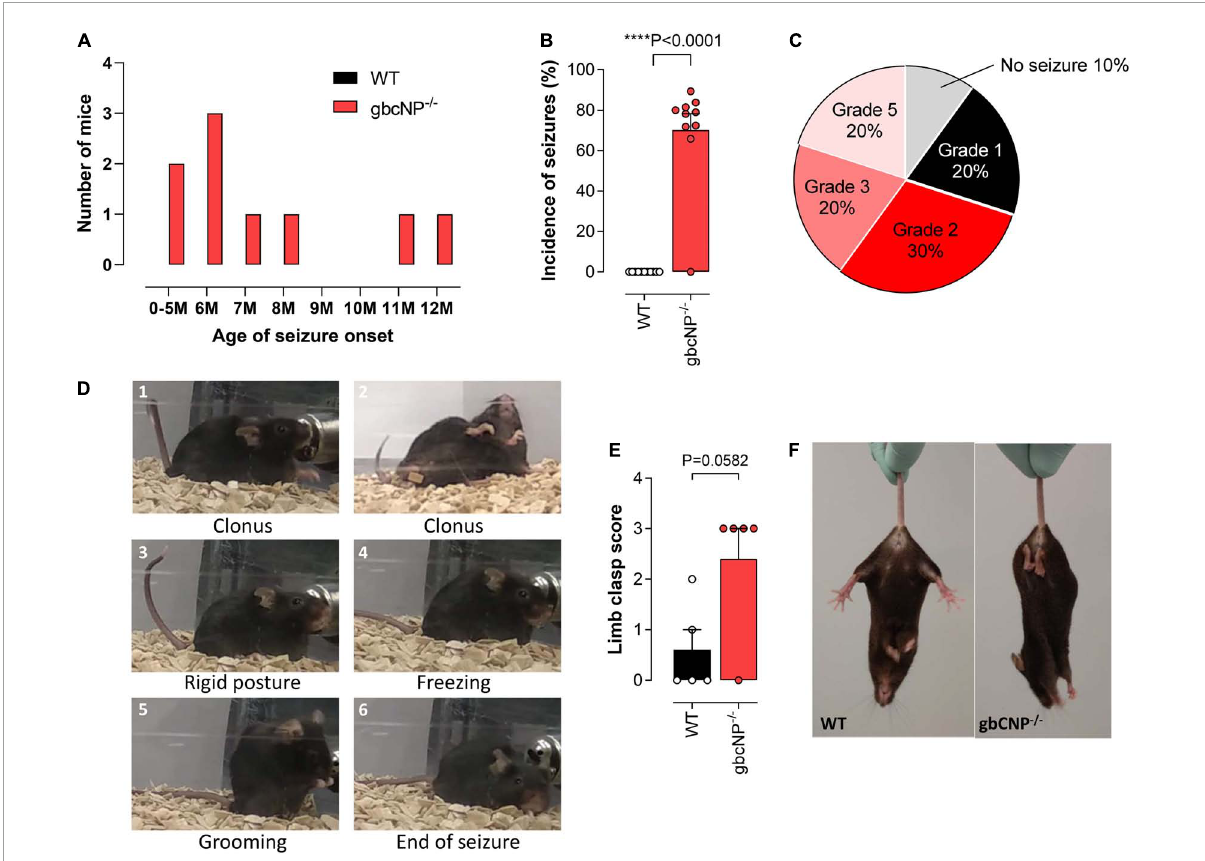
FIGURE4 Aged gbCNP - / - mice exhibited seizures. Age of seizure onset in months (M) in wild-type (WT) and global CNP knockout (gbCNP - / - ) mice (A) . Incidence of seizures (B) . Distribution of the seizure severity according to the Racine scale (0 – No seizure; 1 – Immobility, twitching; 2 –